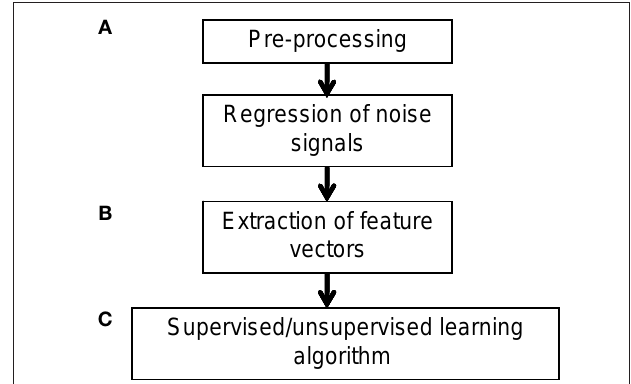
FIGURE 1 | Example workfl ow for pattern classifi cation analysis. (A) Preprocessing of fMRI data can follow that used for conventional GLM analyses, consisting of slice-timing correction, realignment, and optional spatial normalization and smoothing steps. However, while the GLM can reduce potential noise sources by including signals such as motion parameters and physiological noise models as covariates in the GLM design matrix, MVPA does not typically have a framework for modeling confounds. Thus, when applying MVPA to the raw time-series, expected confounds should be removed from the data prior to performing MVPA, such as by obtaining the residuals from a regression over the nuisance variables. In addition, if the features are activation patterns (parameter estimates for a particular model), one may wish to fi rst run a GLM analysis on the fMRI data and extract the relevant contrast estimates. (B) Next, the pre-processed data should be transformed into “feature vectors”. This involves creating, for each data point (e.g., subject) a vector in which the i th entry corresponds to the value of the i th feature for that data point. Feature selection may be applied to